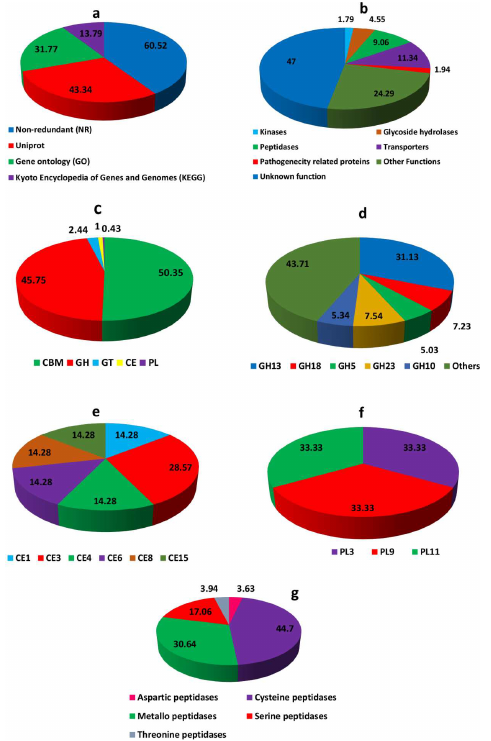
Fig 2. Functional annotationof the T. indica effector candidates (a) Gene annotationof predicted genes using NCBI non-redundant(NR), Uniprot,GeneOntology(GO), KyotoEncyclopediaof GenesandGenomes (KEGG) databases. (b) Percentage distributionof the proteinswith distinct enzymatic functions.(c) Summary of the CAZymecategories:carbohydrate-bindingmodules(CBMs), carbohydrate esterases (CEs), glucoside hydrolases (GHs), glycosyltransferases (GTs), polysaccharidelyases(PLs). (d) Percentdistributonof most abundantGlycosylhydrolases(GH). (e) Percentdistributonof most abundantcarbohydrate esterases(CEs). (f) Percentdistributonof most abundantof most abundant polysaccharidelyases(PLs). The prediction of CAZymes from T . indica effectorcandidatesandtheir classification wereperformedusingtoolsfrom the